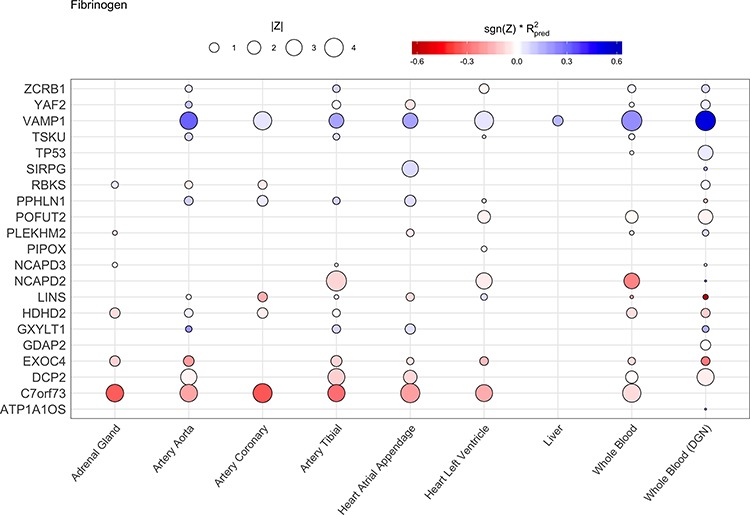
Z-scores for novel gene GReX-trait association across relevant tissues for fibrinogen. Comparison of Z-scores across all cardiovascular trait-assessed tissues for a single trait, fibrinogen, demonstrating concordance of effects for each gene. Size of the point represents magnitude, color indicates direction of effect (blue points are positively associated with the trait, red points are negatively associated with the trait), and shade indicates the R2 from the prediction model. Missing points indicate that there is no model available for the given gene in that tissue.